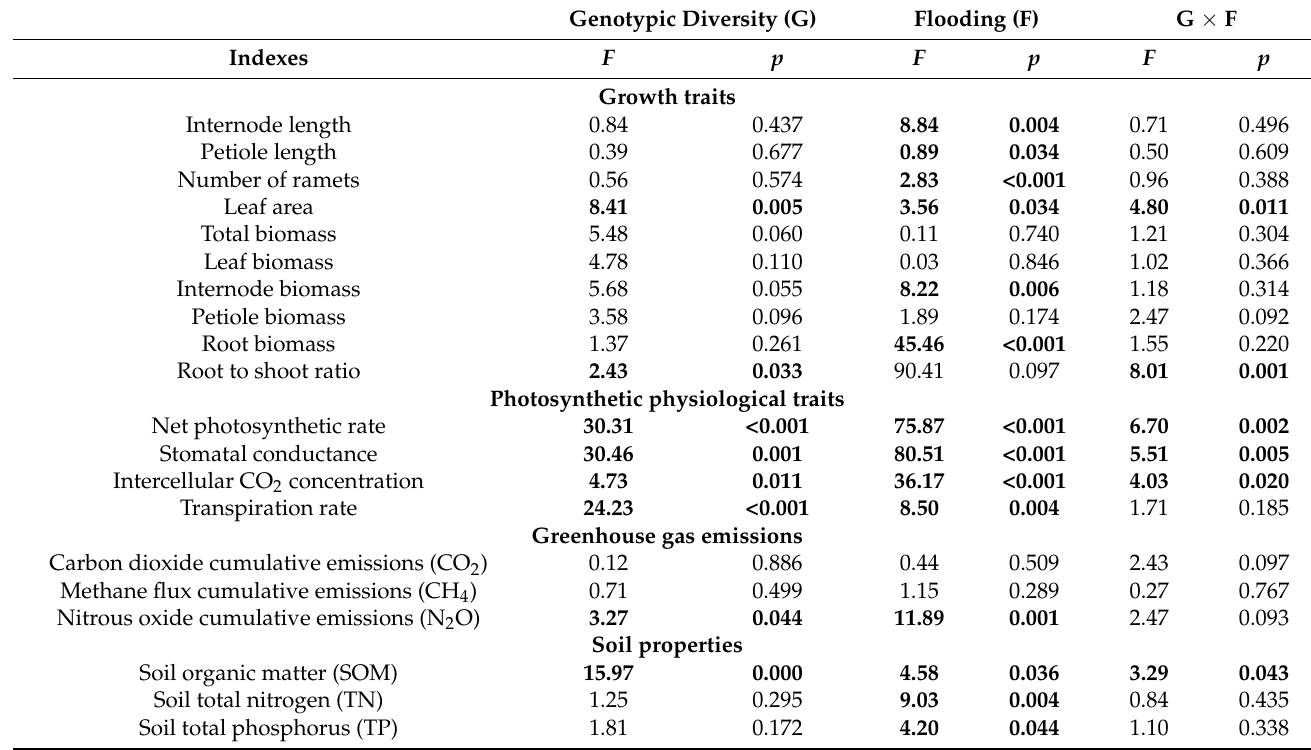
Table 1. ANOVAs for effects of genotypic diversity and flooding on the growth and physiological traits of H. vulgaris , greenhouse gas emissions and soil nutrient in wetland